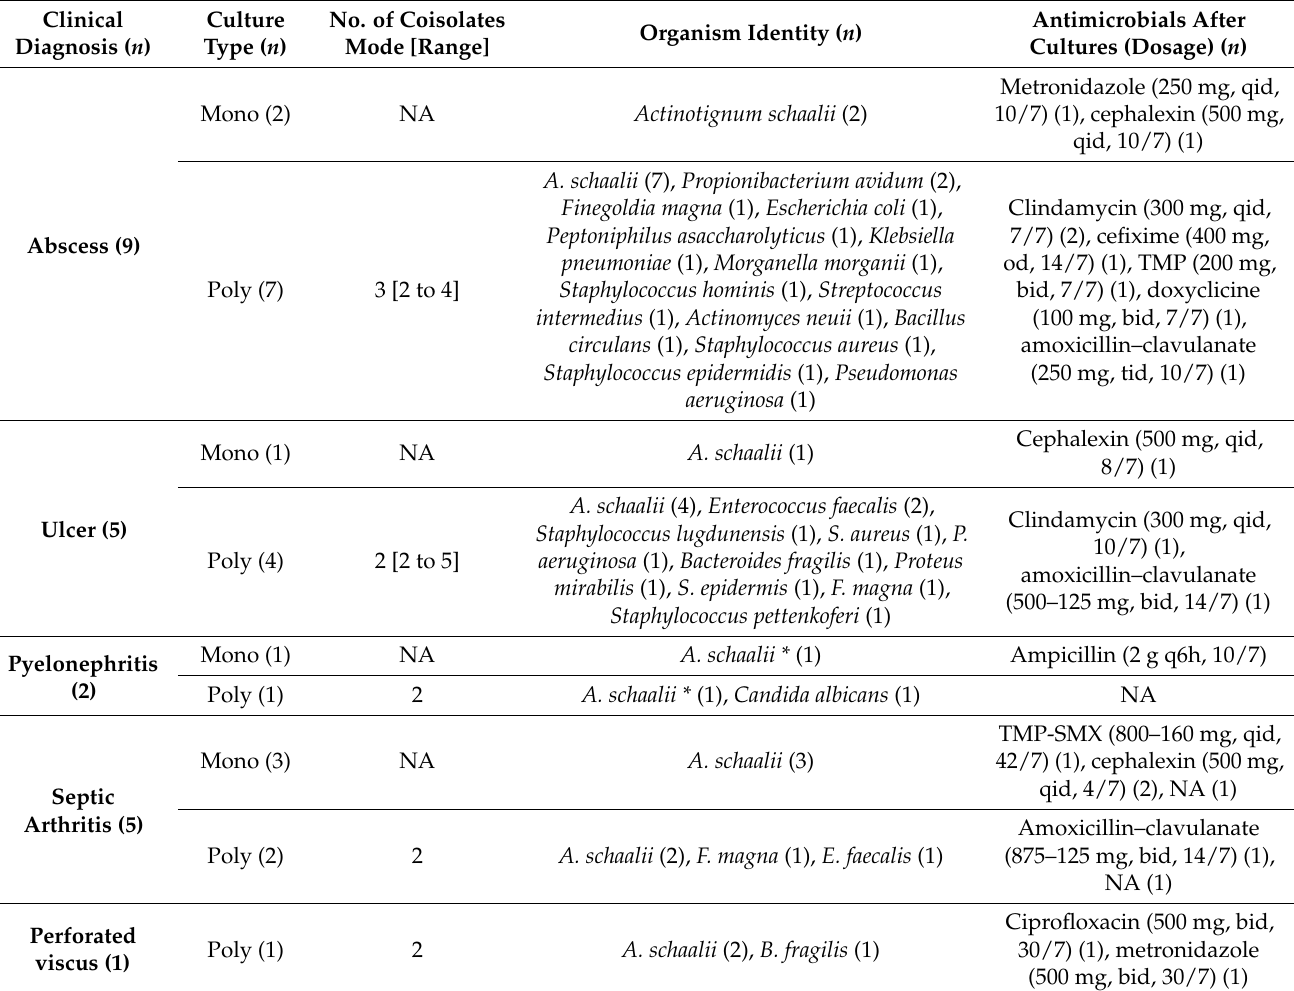
Table 3. Summary of monomicrobial and polymicrobial culture results and subsequent antimicro- bial